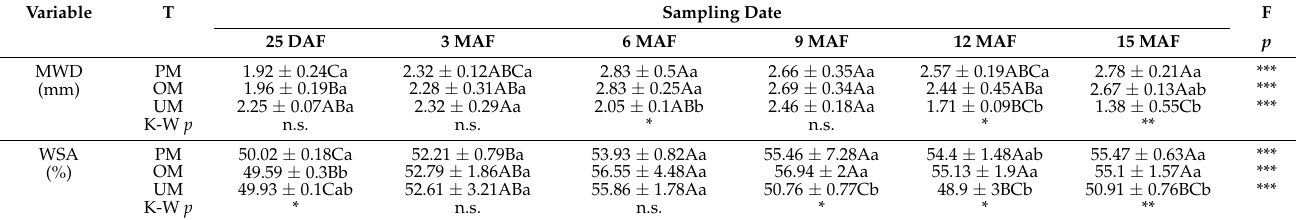
Table 3. Mean weight diameter (MWD) and water stable aggregates (WSA) of the soil in the pine mulch (PM), olive mulch (OM), and unmulched (UM) treatments during the studied period (T, treatments; DAF, days after fire; MAF, months after fire) (mean ± standard deviation). Different letters indicate significant differences between sampling dates (capital letters) and treatment (lowercase letters). Kruskal–Wallis (K-W) (* p < 0.05, ** p < 0.01, *** p < 0.001, and n.s. non-significant at p < 0.05) are shown for each comparison between treatments, and Friedman ANOVA (F) between sampling